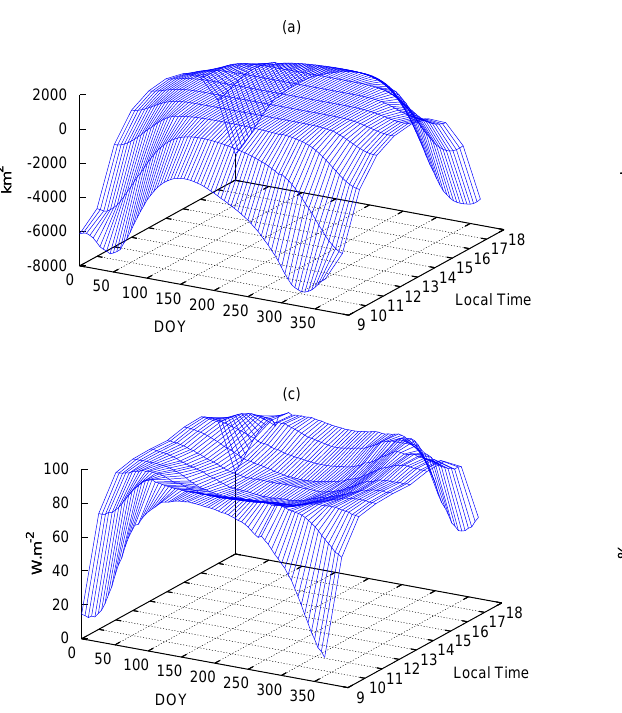
Figure 11. Hourly and daily variation of differences between sub-pixel and pixel level corrections for: ( a ) Shadow binary factor, in km 2 of lightened area; ( b ) ratio between incidence and zenith solar angle in radian; ( c ) Total irradiance values in W·m − 2 ; ( d ) Total irradiance normalized values in